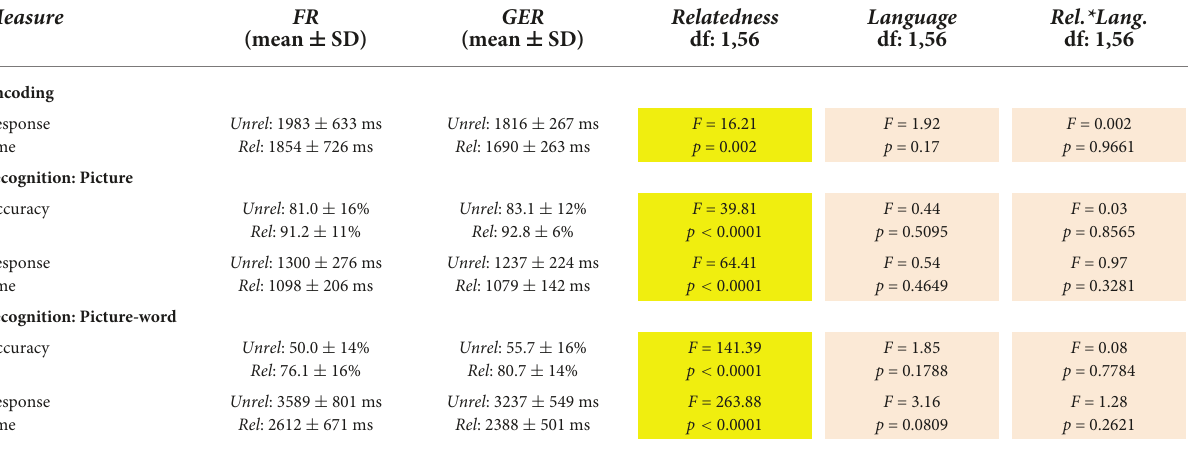
TABLE 5 Modulation of semantic congruency effects on behavior by